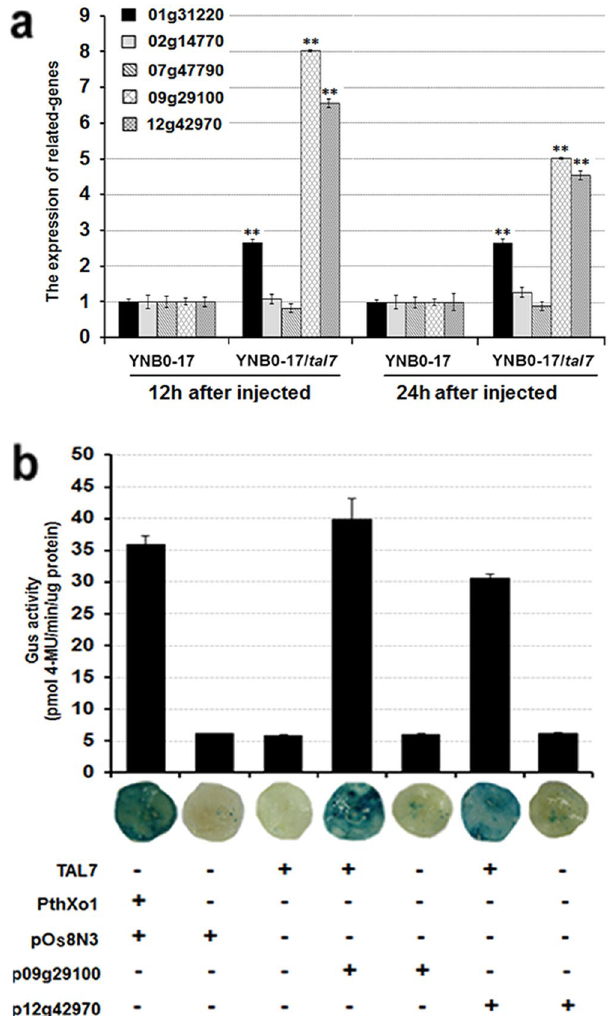
Figure 3. Xoc Tal7 targets rice genes Os09g29100 and Os12g42970 . ( a ) The expression of candidate targets of Tal7. Xoc strains YNB0-17, and YNB0-17( tal7 ) were infiltrated into IR24 rice, and the expression of five rice genes ( Os01g31220 , Os02g14770 , Os07g47790 , Os09g29100 , and Os12g42970 ) was measured 12 and 24 hpi by real time qRT-PCR. The expression levels of Actin and 18S rRNA used as internal standards. The asterisks in each horizontal data column indicate significant differences at P = 0.01 using the Student’s t test. Data are the mean ± SD of triplicate measurements from a representative experiment; and similar results were obtained in two other independent experiments. ( b ) Transcriptional activation of rice genes Os09g29100 and Os12g42970 by TALEs of Xoc Tal7. The TALE PthXo1 from Xoo and its target rice gene, Os8N3 (pOs8N3), were used as a positive control. Reporter fusions containing the rice promoters fused to GUS were codelivered via A . tumefaciens into N . benthamiana with ( + ) and without ( − ) constructs encoding TAL7 and PthXo1. pOs8N3, p09G29100 and p12g42970 represent the Os8N3 , 09g29100 and 12g42970 promoters fused to GUS (see Methods). For quantitative assays, two leaf discs (0.9 cm diameter) were sampled 2 dpi, and GUS activity was determined using 4-methyl-umbelliferyl- β -D-glucuronide (MUG). 4-MU is 4-methyl-umbelliferone. Error bars indicate standard deviations (n = 3 samples from different plants). For qualitative assays, GUS activity in excised leaf discs was determined 3 dpi with X-Gluc (5-bromo-4-chloro-3-indolyl-b-D-glucuronide). A blue color indicatesa positive reaction. All experiments were performed twice with similar